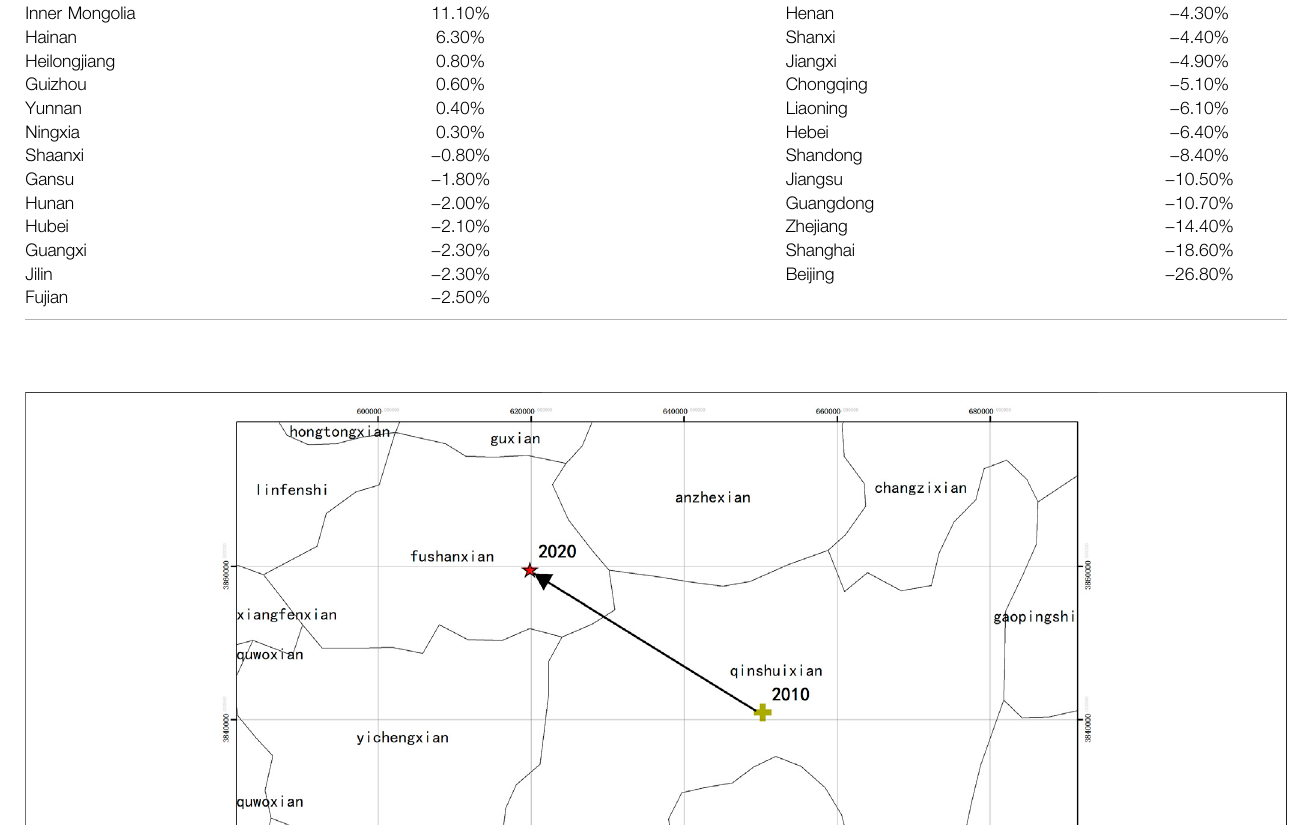
Frontiers in Environmental Science |